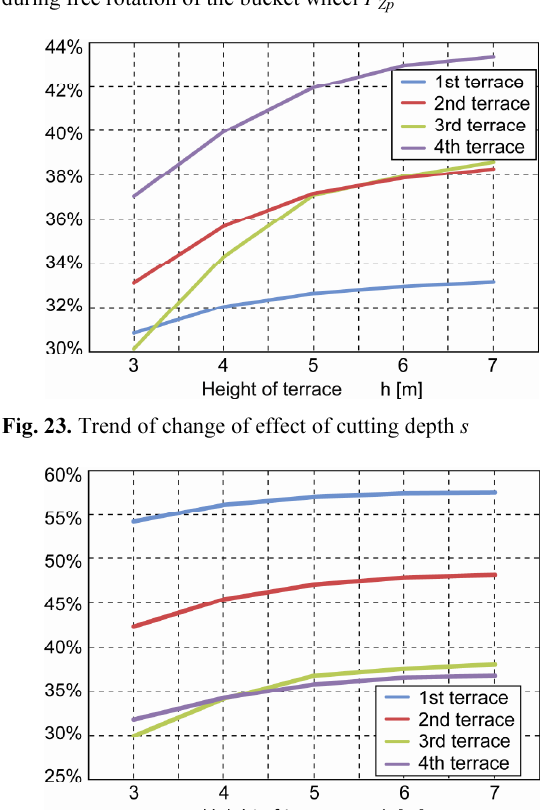
Fig. 22. Trend of change of effect of input power of motors during free rotation of the bucket wheel P Zp